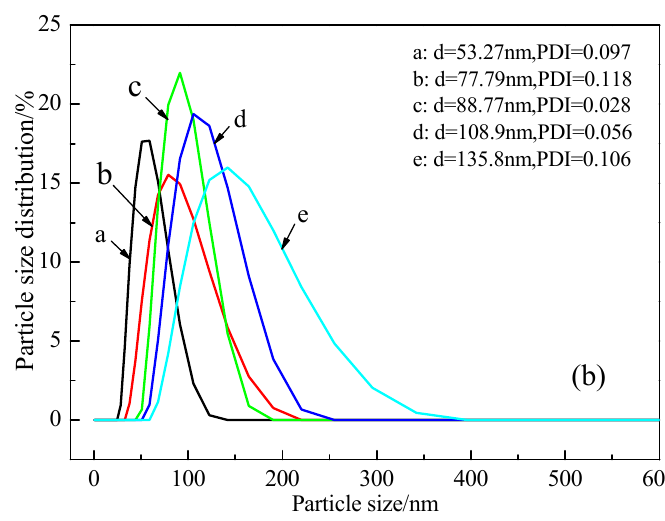
Figure 2. IR spectra ( a ) and particle size distribution ( b ) of the SiO 2 nanoparticles.